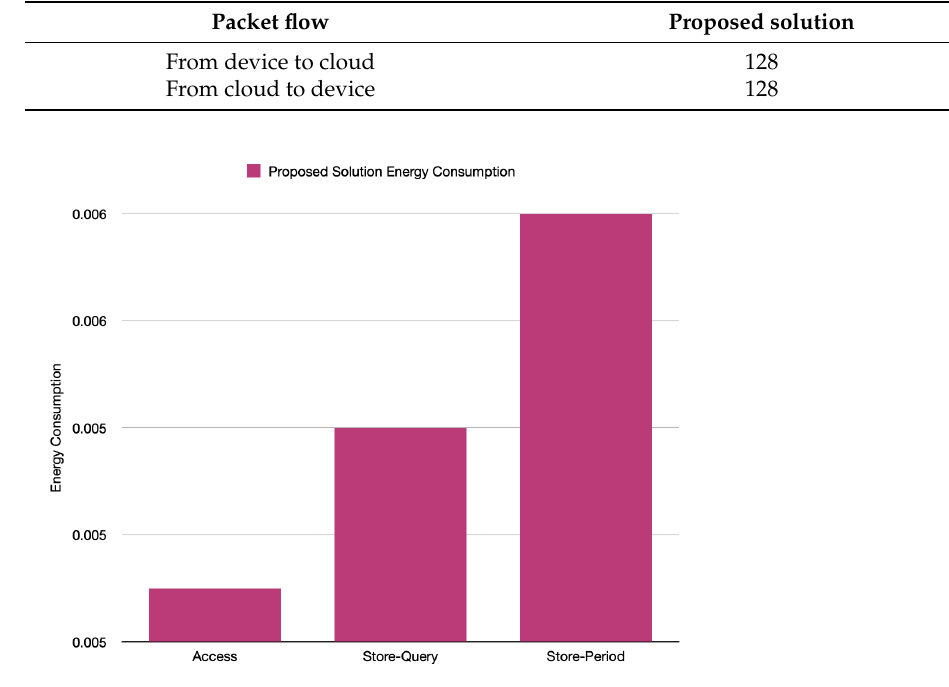
Figure 10. Energy consumption overhead (CPU and Tx) of healthcare